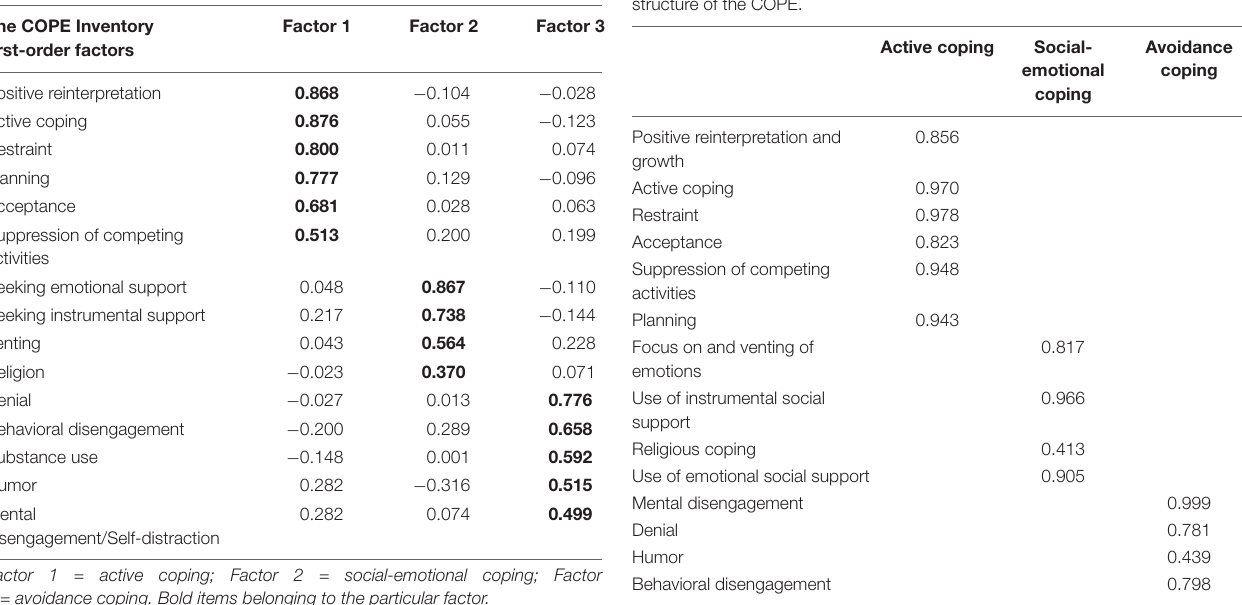
TABLE 1 | Exploratory factor analysis (EFA) factor loadings of three-factor model of the COPE Inventory scores.